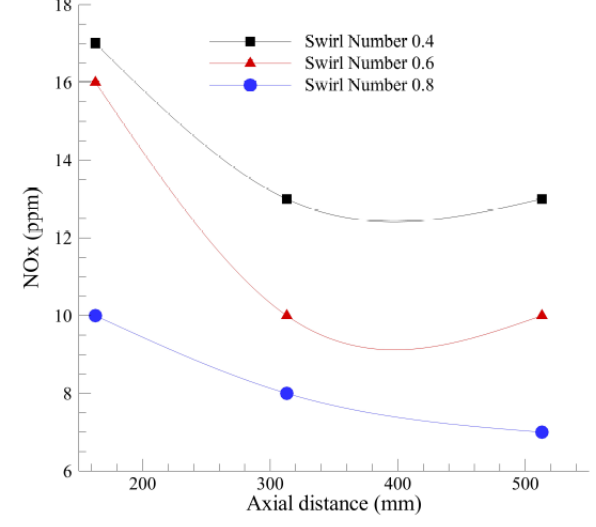
Figure 17: Axial NO x profiles (Swirl number: 0.6,